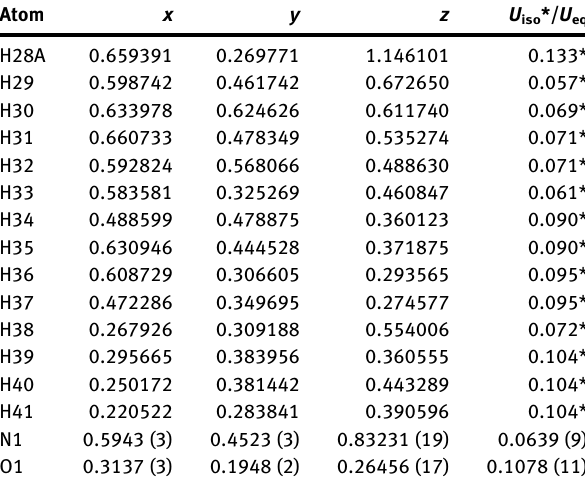
organic layer was dried with Na by fi ltration and evaporation was recrystallized with meth- anol to obtain colorless block crystals of the compound. 58% yield. Elemental analysis calcd. (%) for C H, 10.14; N, 3.44; O, 3.92 Found: C, 82.50; H, 10.14; N, 3.44.